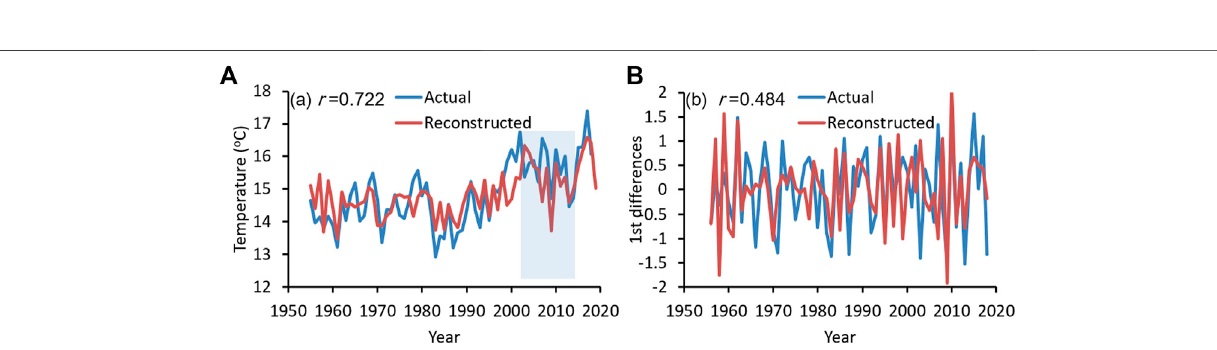
Frontiers in Earth Science |